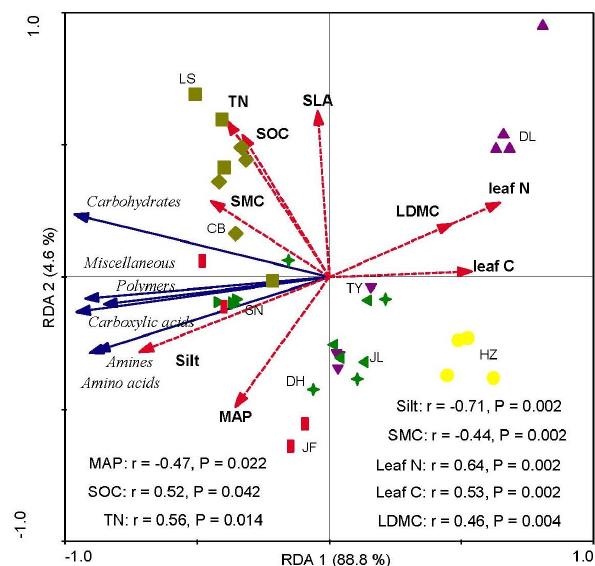
Figure 4. Redundancy analysis (RDA) ordination biplot of soil mi- crobial carbon sources use efficiency and environmental properties. The representatives of different colors are shown in Fig. 2. The dot- ted lines and solid lines represent the environmental variables and lipid signatures and carbon sources, respectively. The abbreviations of the variables in this figure are as follows: MAP, mean annual precipitation; LDMC, leaf dry matter weight; leaf C, leaf carbon content; leaf N, leaf nitrogen content; and SLA, specific leaf area. Soil properties included SMC, soil moisture content; Silt, soil silt content; TN, soil total nitrogen; and SOC, soil organic carbon. The abbreviations of the sampling sites are given in Table